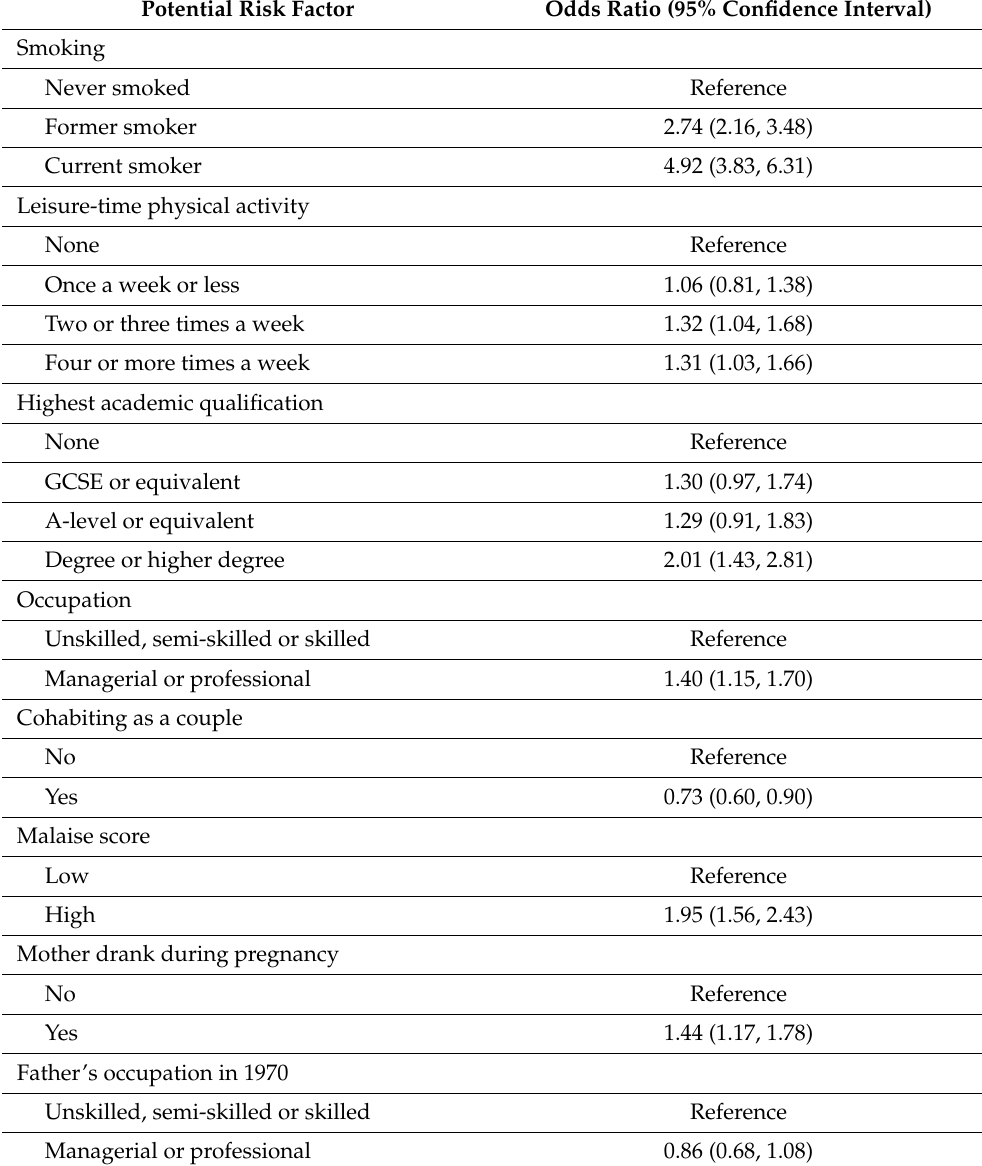
Table 4. Longitudinal associations of modifiable and non-modifiable risk factors with problematic drinking in